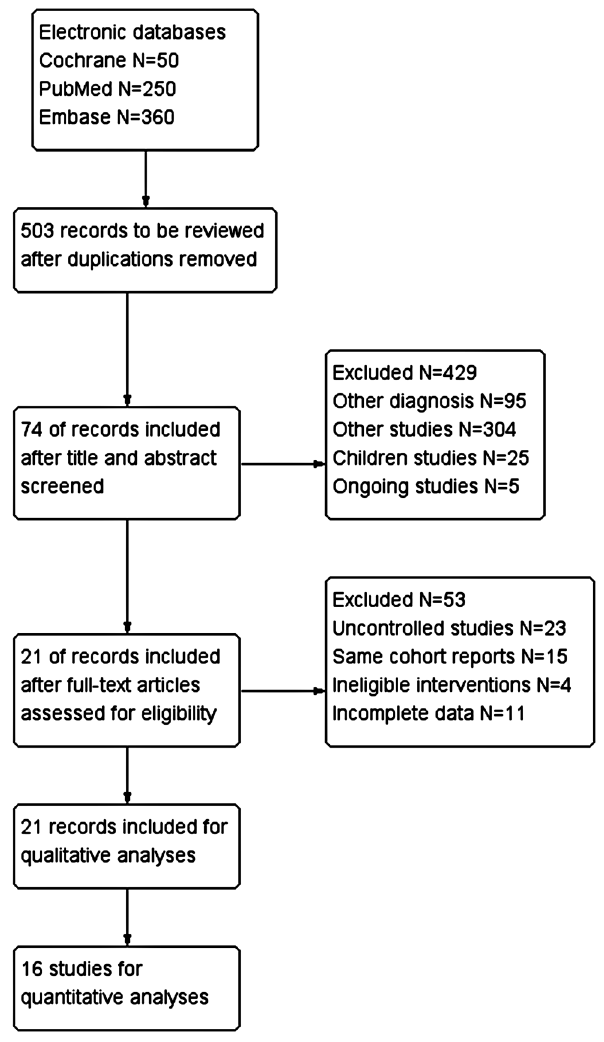
Figure 1. Flow diagram of study selection.